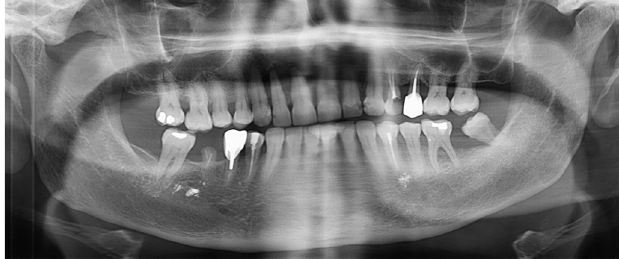
Fig. 1. Orthopantographic showing moderate generalized alveolar bone loss.